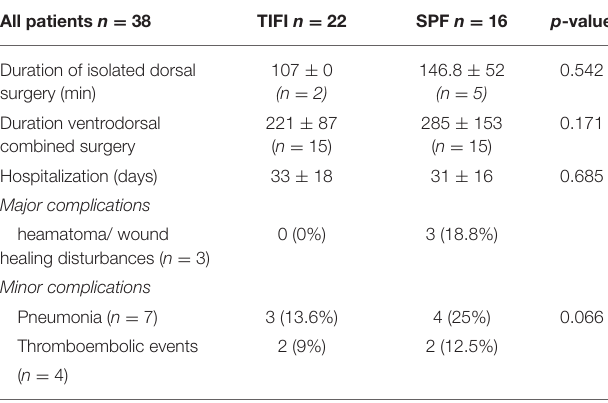
Surgical details were tested using the t-test for unmatched samples; complications were evaluated using the chi-squared test for cross table evaluation. Values are given as mean (range; SD) or absolute numbers with percentage.